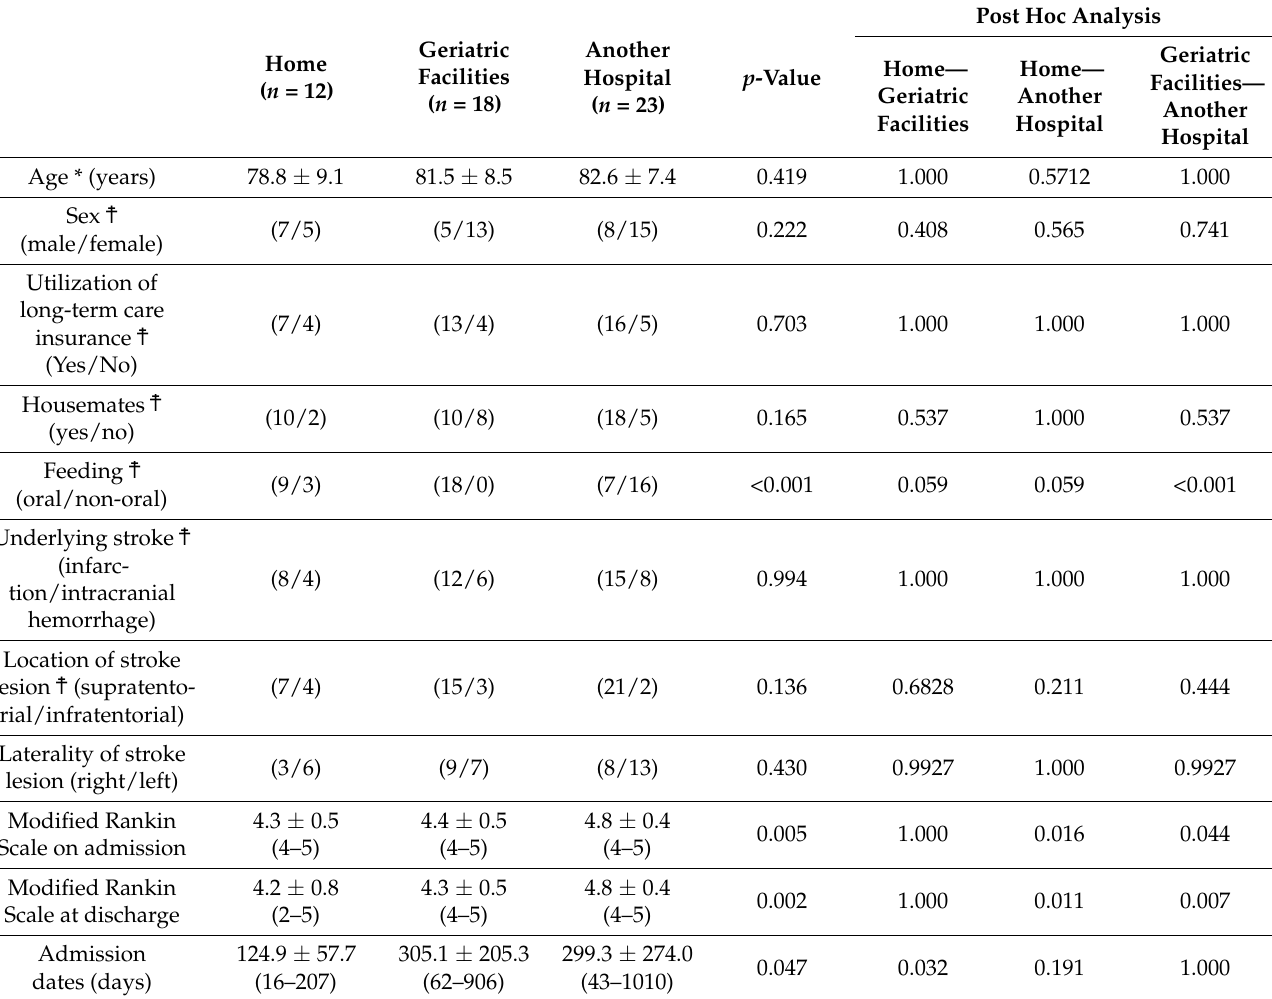
Table 1. Comparison of the fundamental information and measurements among the three groups.